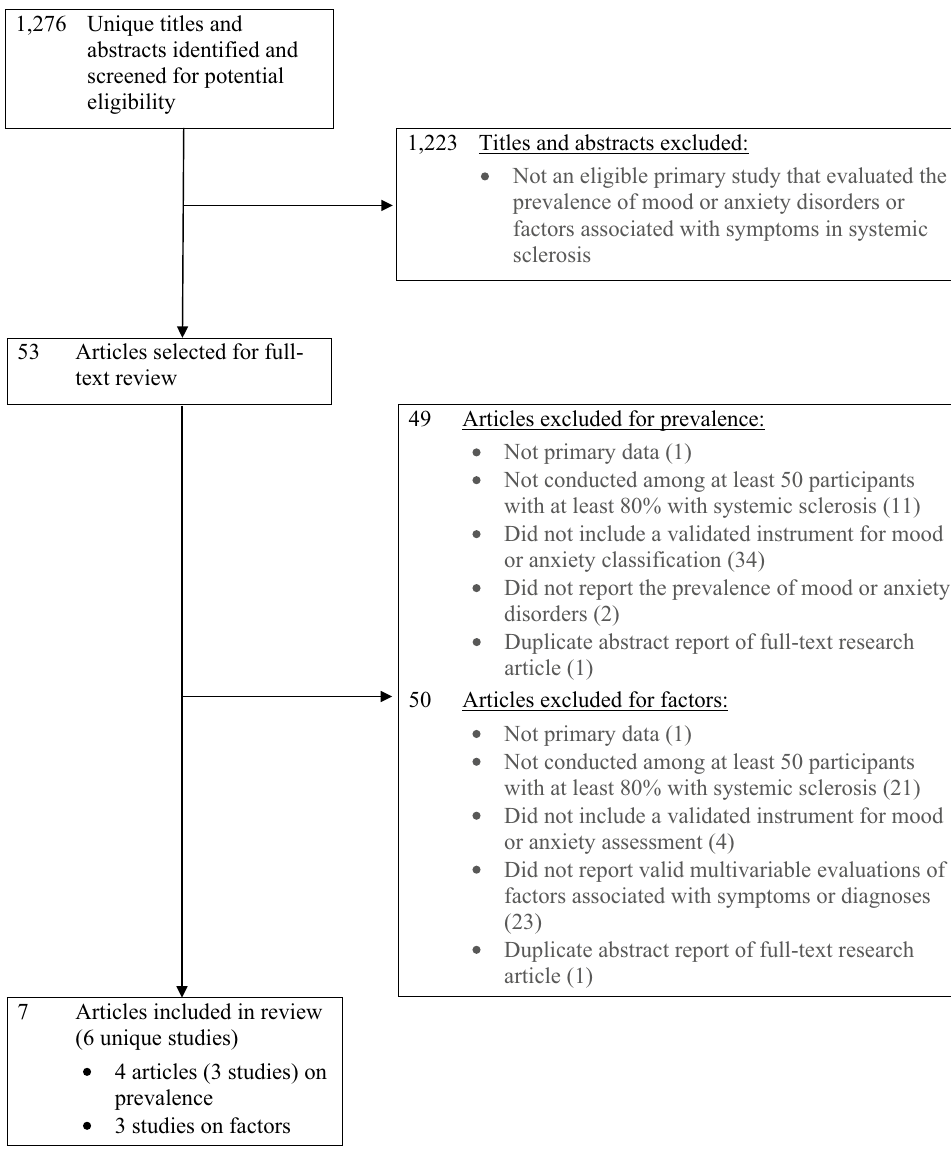
Figure 1. Flow diagram of selection of eligible